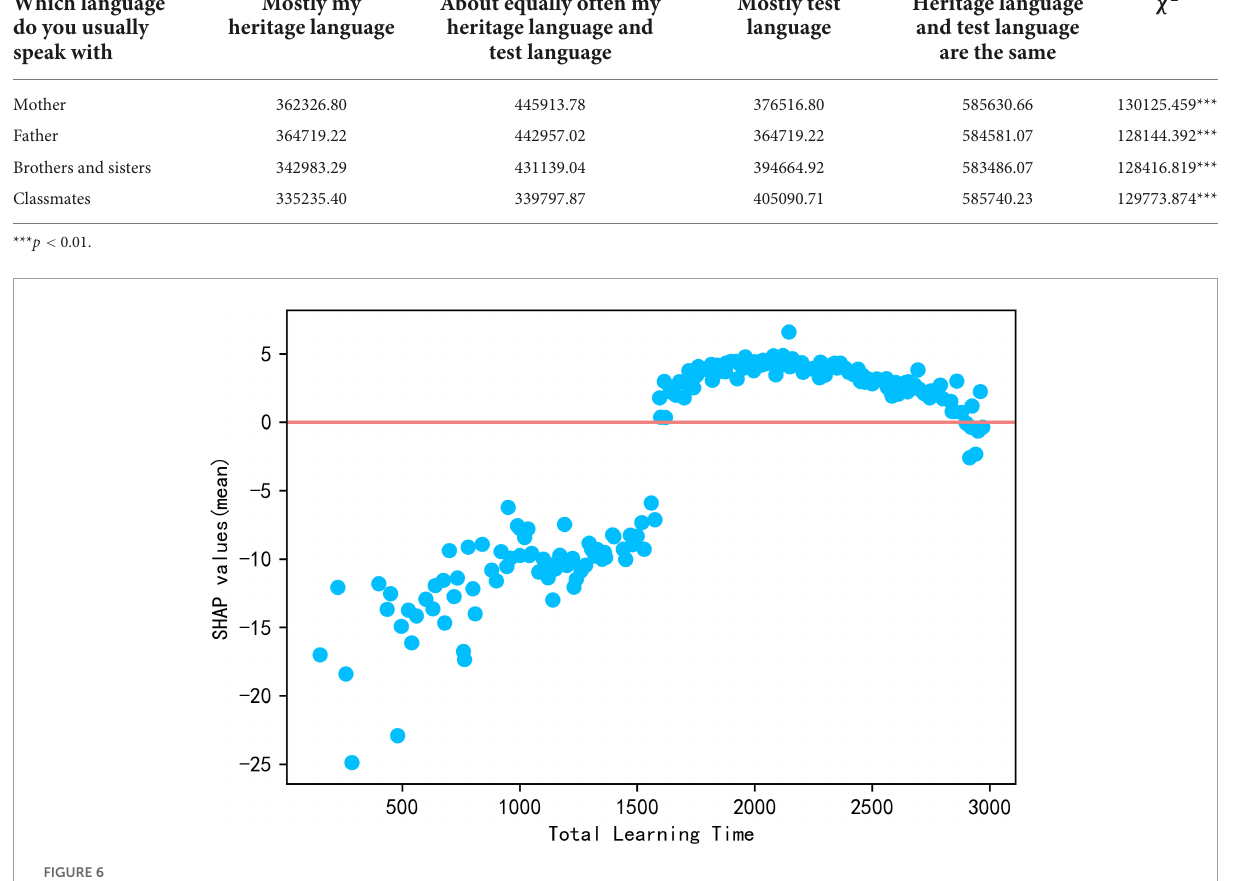
FIGURE6 The scatter plot of total learning time and Shap